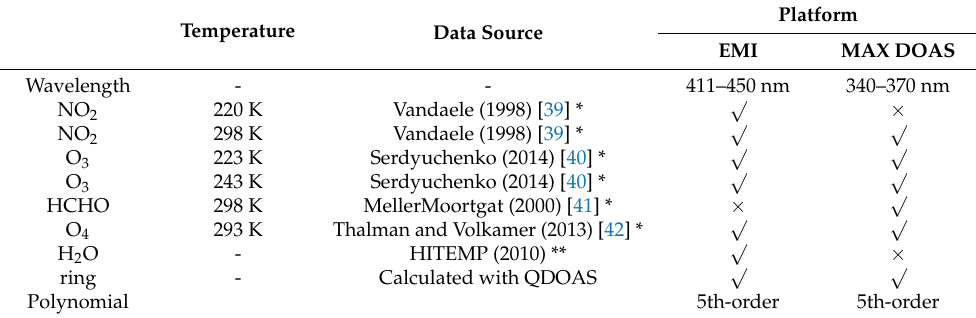
Table 1. The DOAS retrieval settings for the EMI and MAX-DOAS spectral